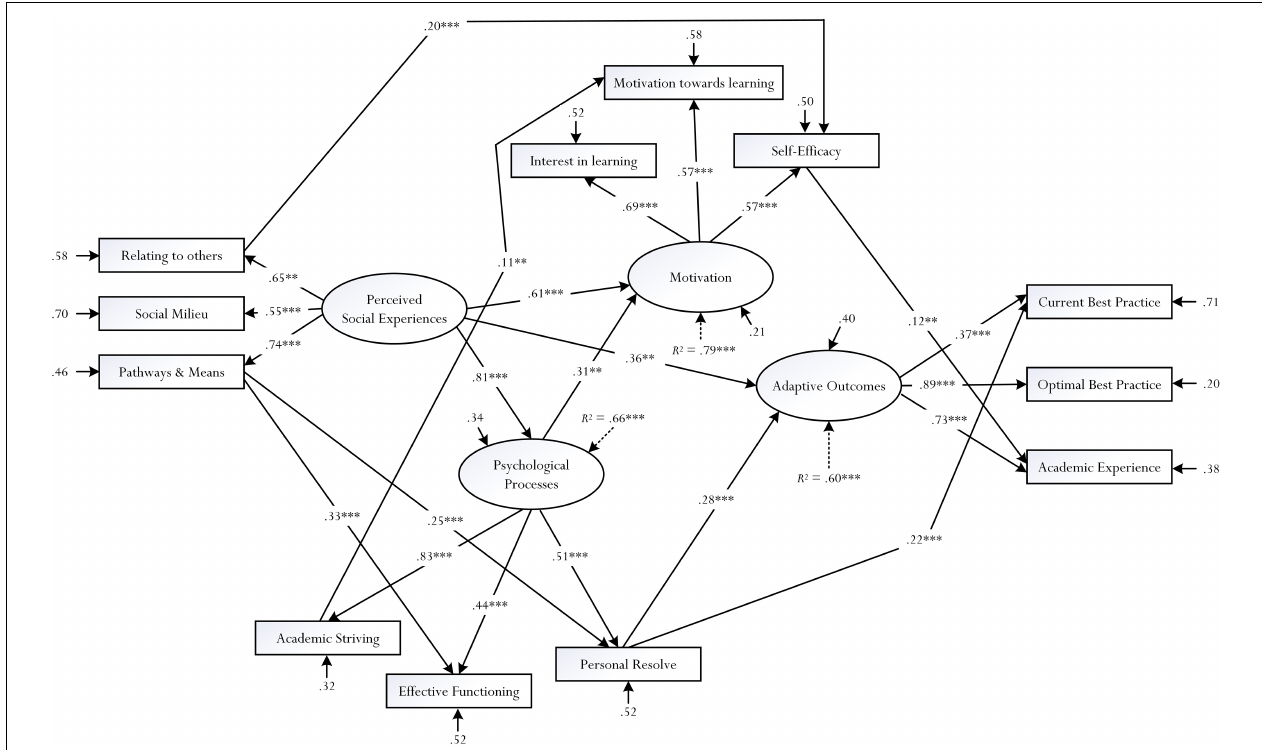
FIGURE 3 | Final solution of model M 7 . ∗ p < 0.05, ∗∗ p < 0.01, ∗∗∗ p < 0.001. Non-statistically significant paths have been omitted for